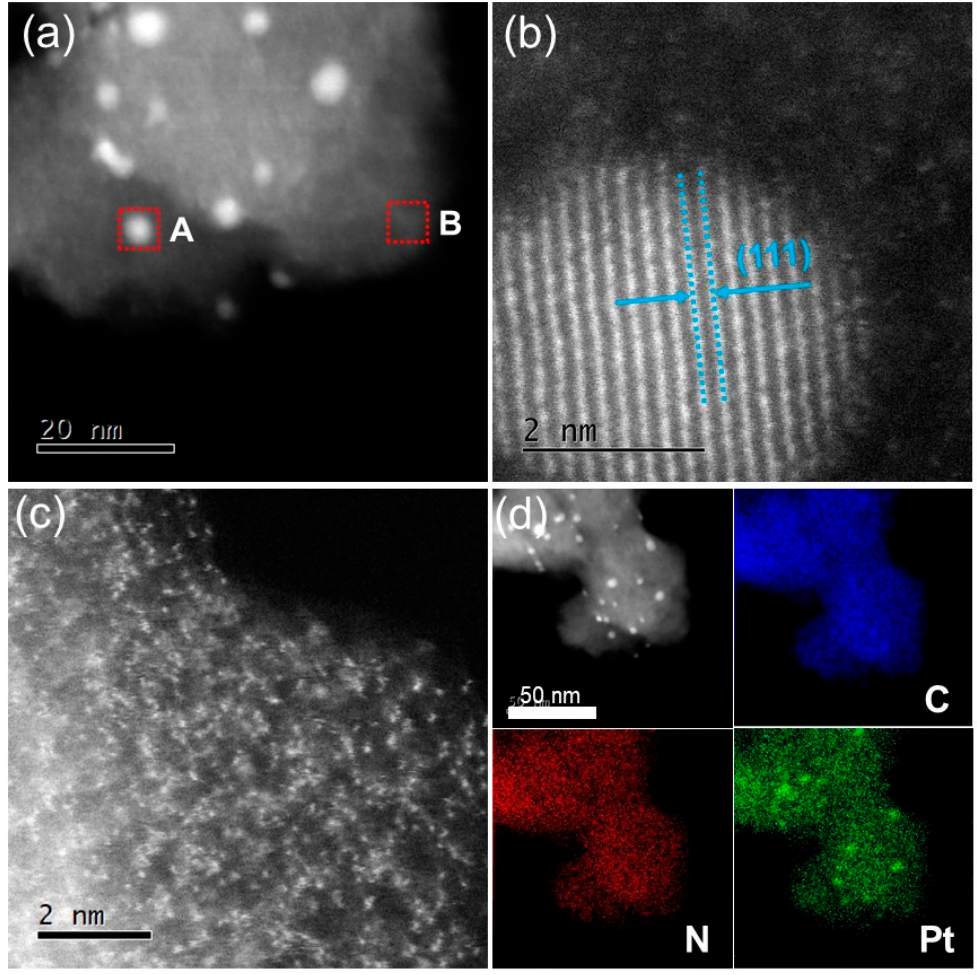
Figure 2 . Morphology and elemental analysis of PC-PtN4-600. HAADF-STEM image ( a ) and high-resolution HAADF-STEM images acquired from the select areas A ( b ) and B ( c ) in ( a ). The HAADF-STEM image and corresponding elemental mapping of C, N, Pt ( d ).